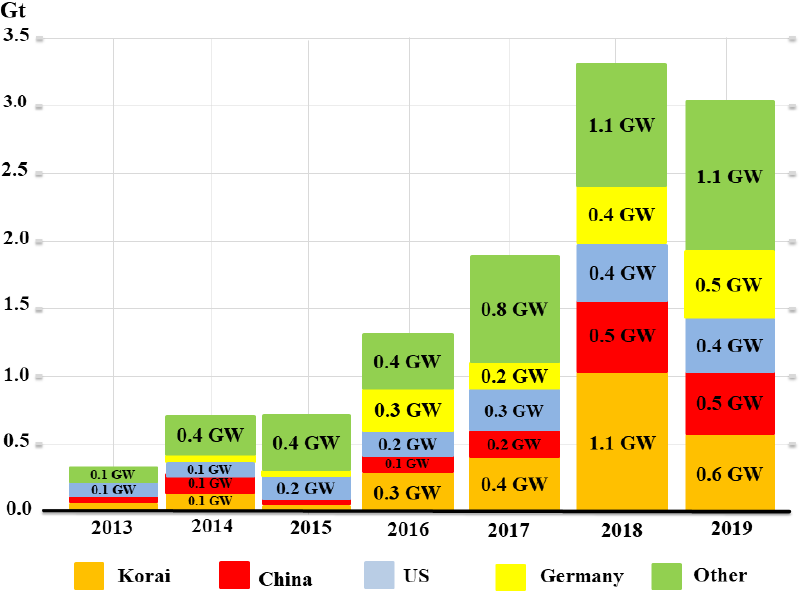
Figure 2. Annual energy storage deployment by countries, 2013–2019 [30].